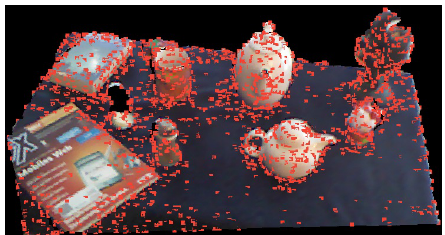
Figure 6: Point cloud with 3D-SIFT keypoints